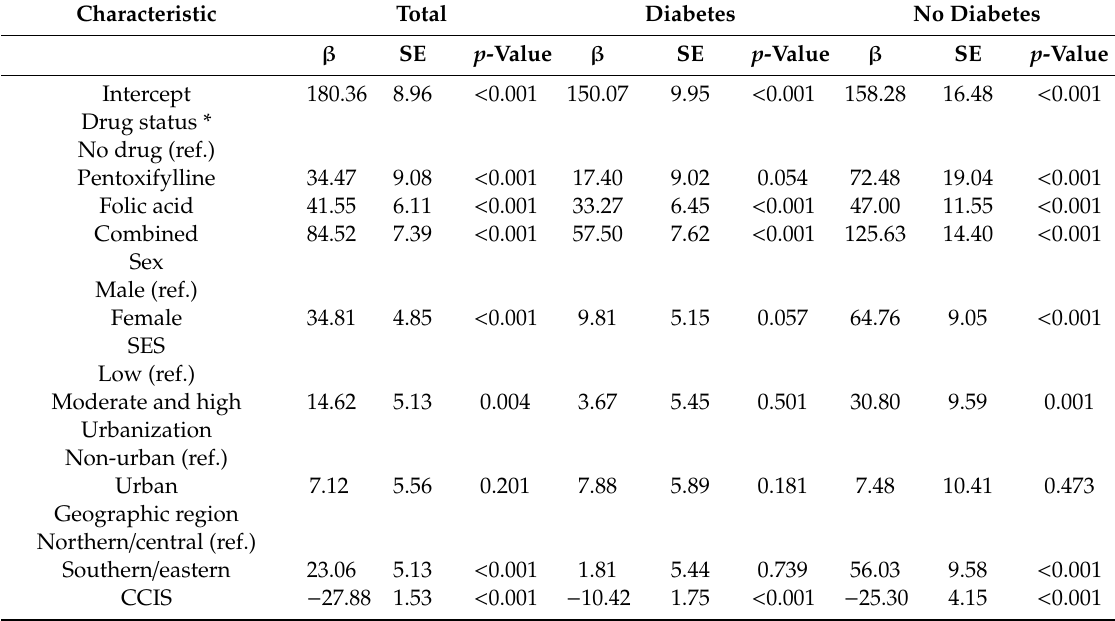
Table 4. Multiple regression